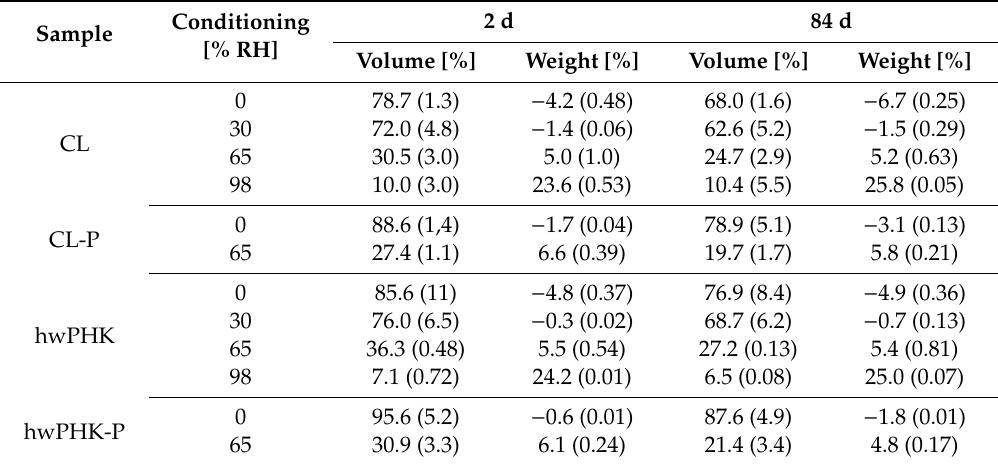
Table 5. Volume and weight changes of studied aerogels in dependence on relative humidity and storage time (% of initial mass and volume right after scCO 2 drying). Numbers in brackets indicate the 95% confidence interval ( n =